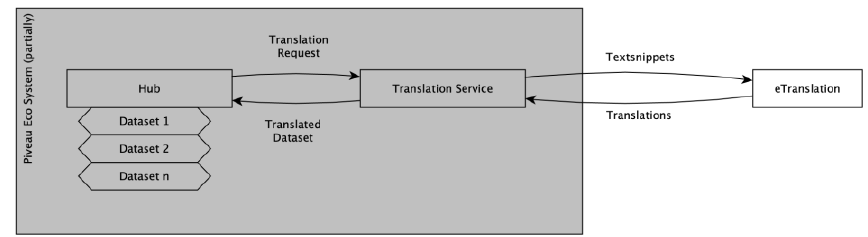
Figure 4: Overview of translation